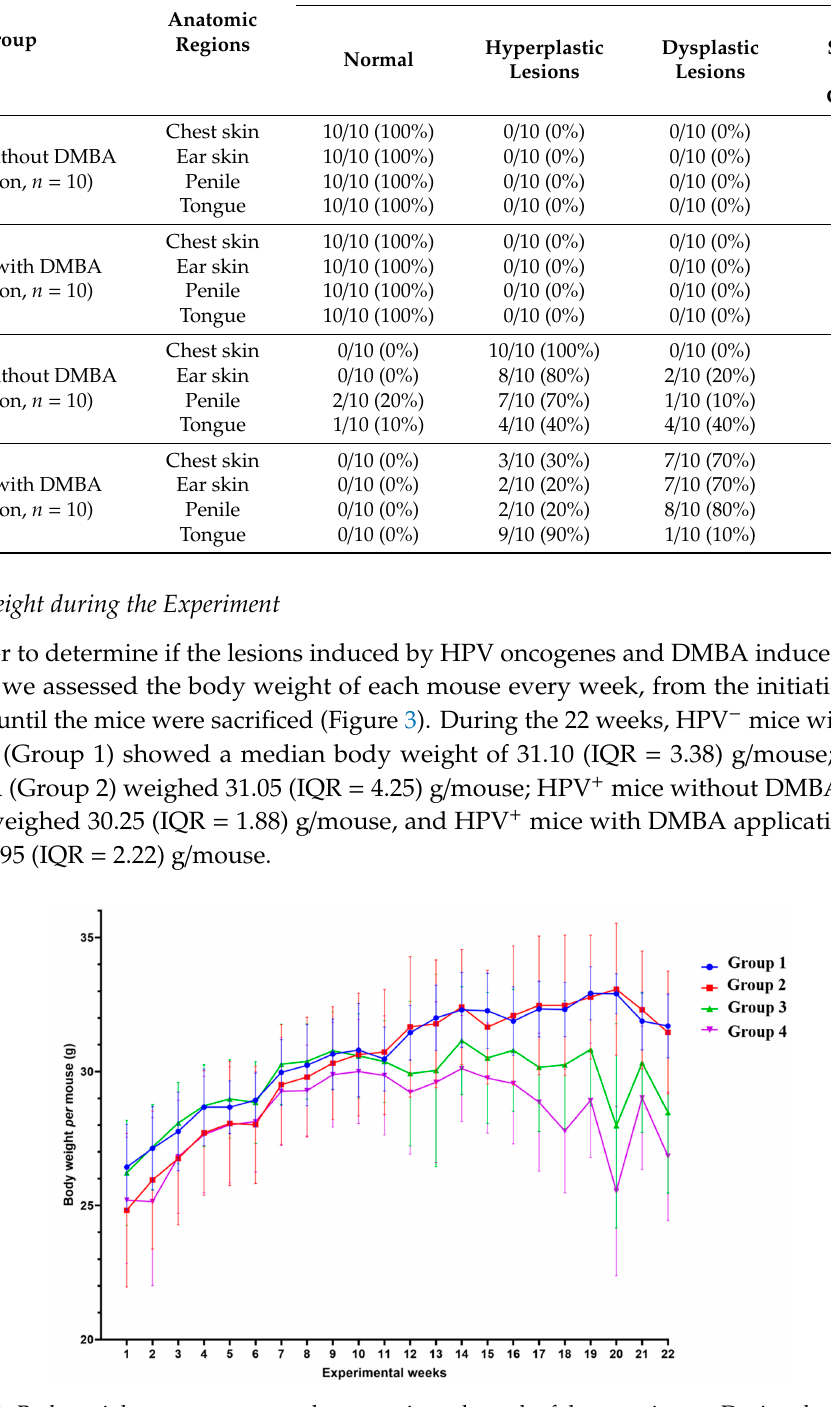
Figure 3. Body weight mean per mouse by group in each week of the experiment. During the 22 weeks of the experiment, transgenic mice (Groups 3 and 4) had lower body weights than matched wild-type mice—Group 3 versus Group 1: p < 0.05; Group 4 versus Group 2: p < 0.01. Among the HPV + mice, 7,12-dimethylbenz(a)anthracene (DMBA)-exposed animals showed lower body weights—Group 4 versus Group 3: p < 0.01. Group 1: HPV − without DMBA application ( n = 10); Group 2: HPV − with DMBA application ( n = 10); Group 3: HPV + without DMBA application ( n = 10); Group 4: HPV + with DMBA application ( n = 10).